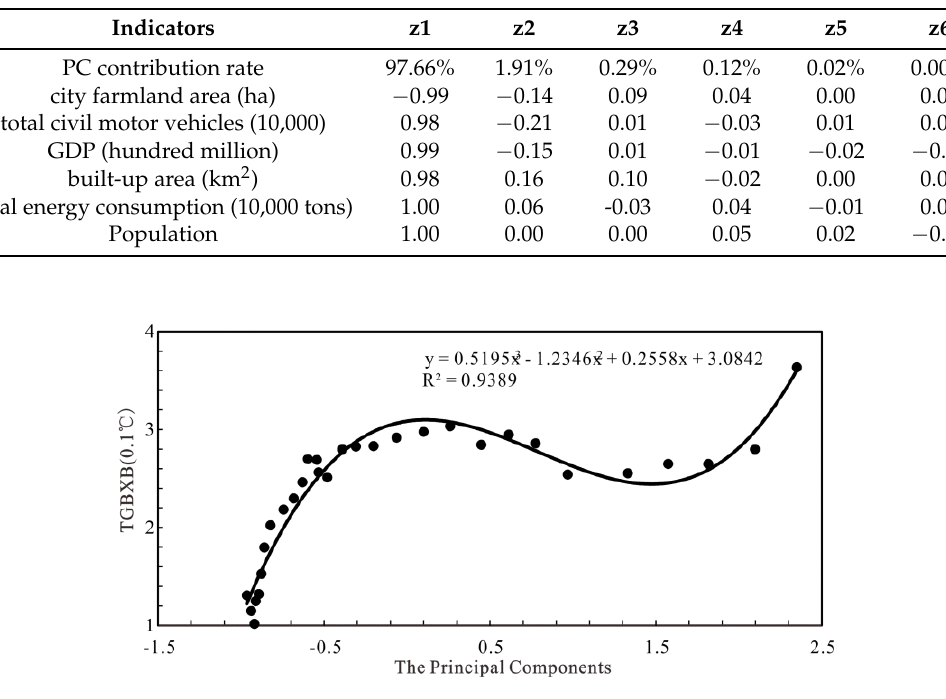
Figure 8 . The scatter plot of the urbanization level and TGBXB. Figure 8. The scatter plot of the urbanization level and